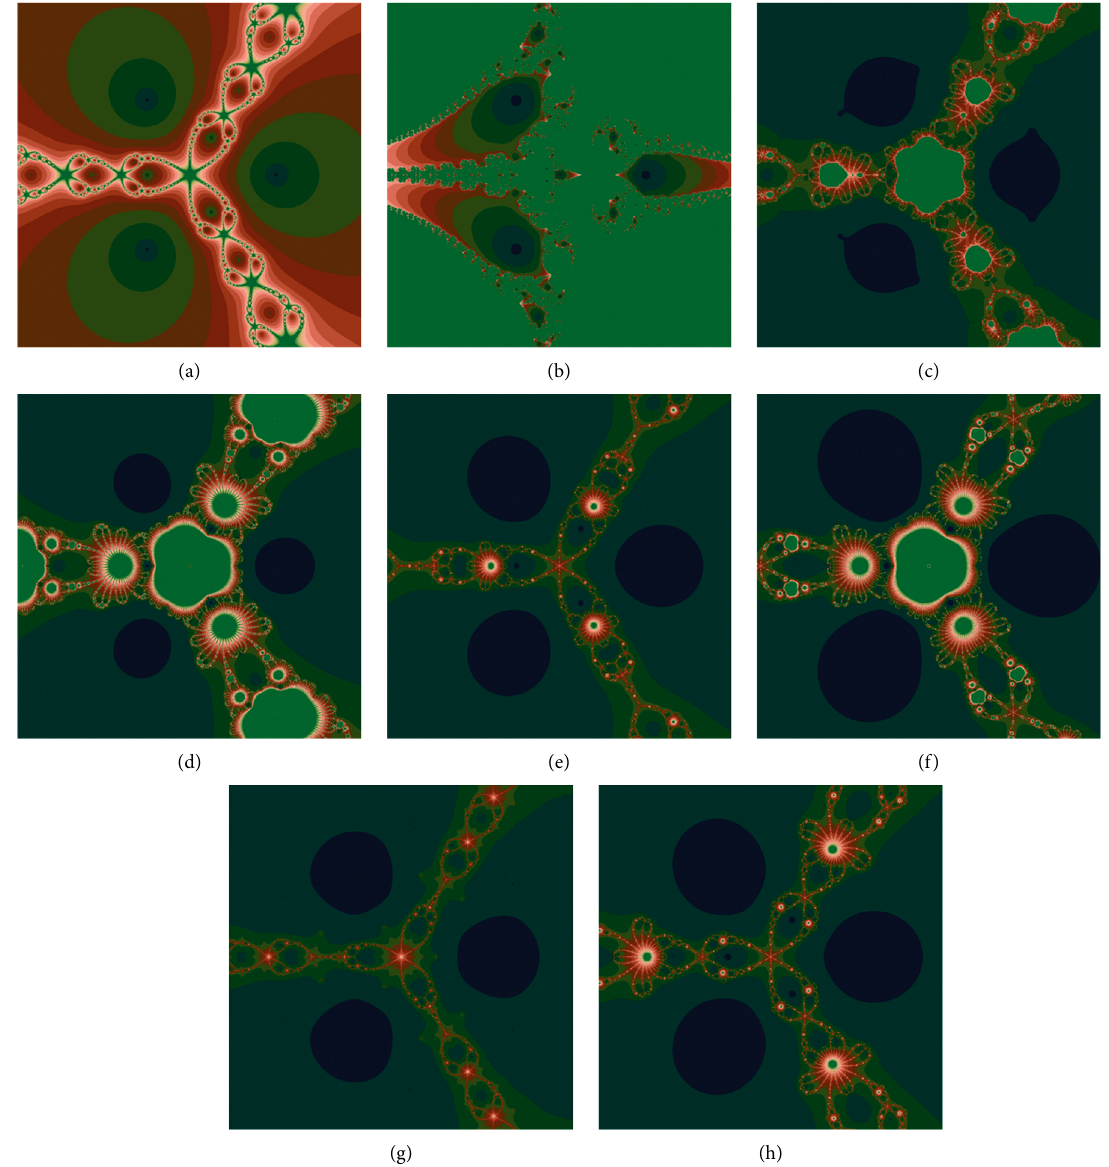
Figure 4: Polynomiographs for q